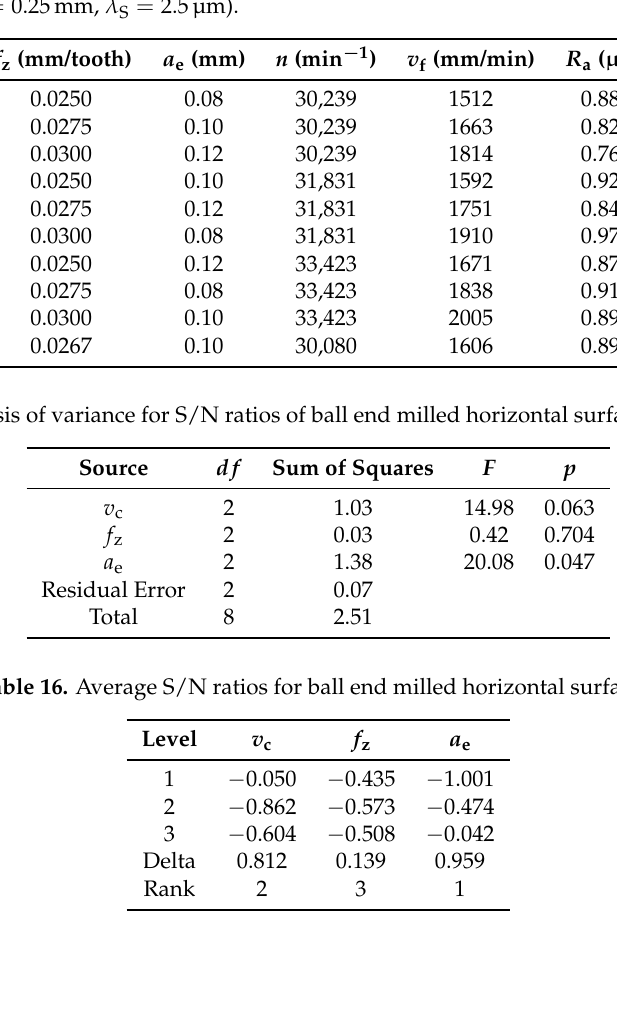
Table 14. Factors and their respective levels for ball end milling of horizontal surfaces, R a provided additionally ( λ C = 0.25mm, λ S = 2.5µm).